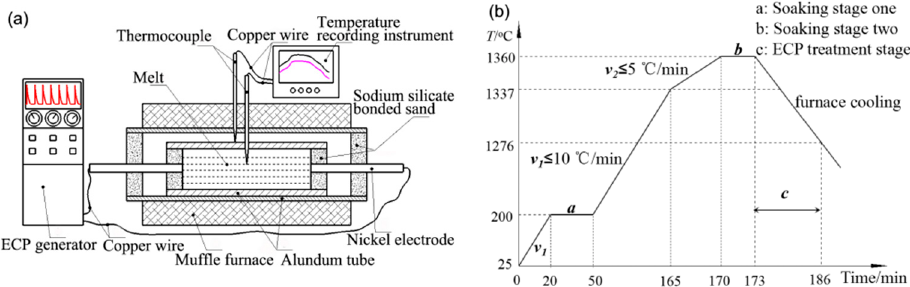
Figure 1. Schematic diagram of ECP treatment device ( a ) and process flow ( b ).